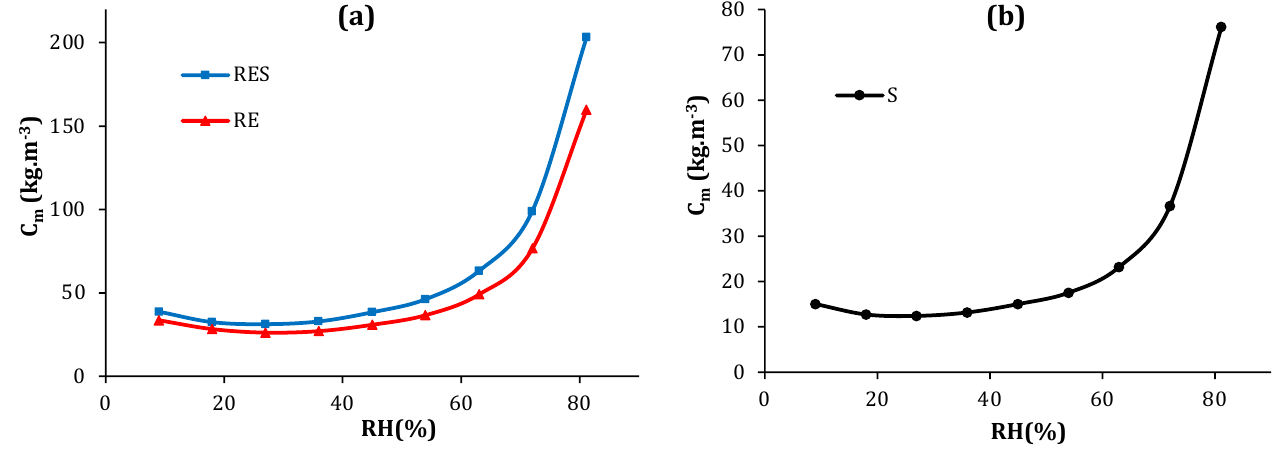
Figure 14. Moisture storage capacity of raw earth, raw earth/straw ( a ), and straw ( b ).